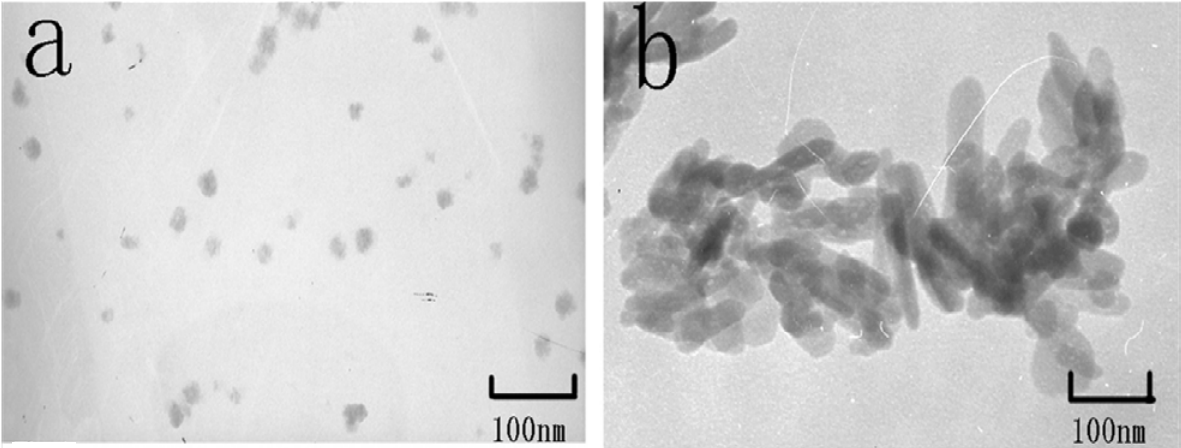
Figure 1. The morphology of the two types of nanoscale HA (nHA). ( a ) spherical nHA; ( b ) rod-like nHA.